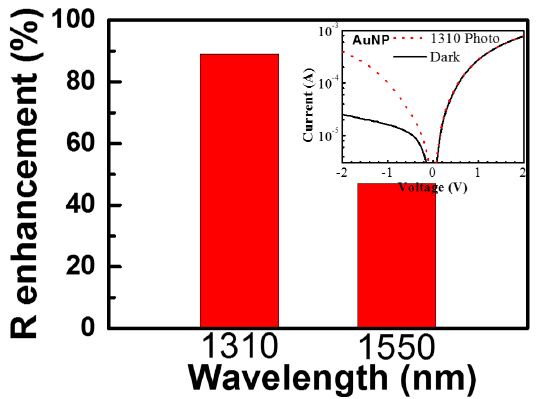
Figure 4. The ratio of responsivity ( R ) enhancement with AuNPs added. The inset shows the IV behaviors of the thin-film Ge detectors with AuNPs coated.